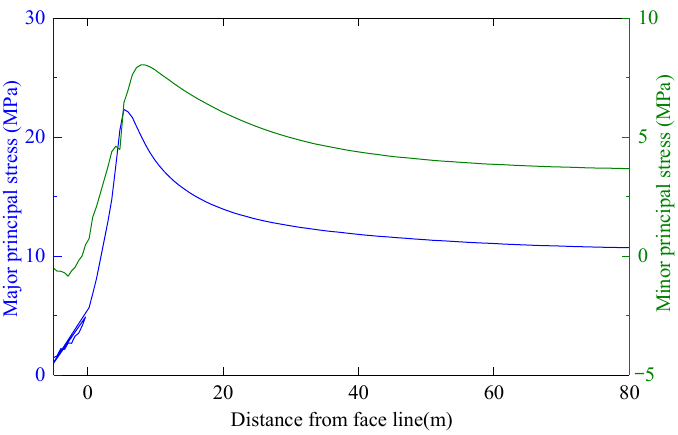
Figure 12. Distribution of the principal stresses along the measuring line.